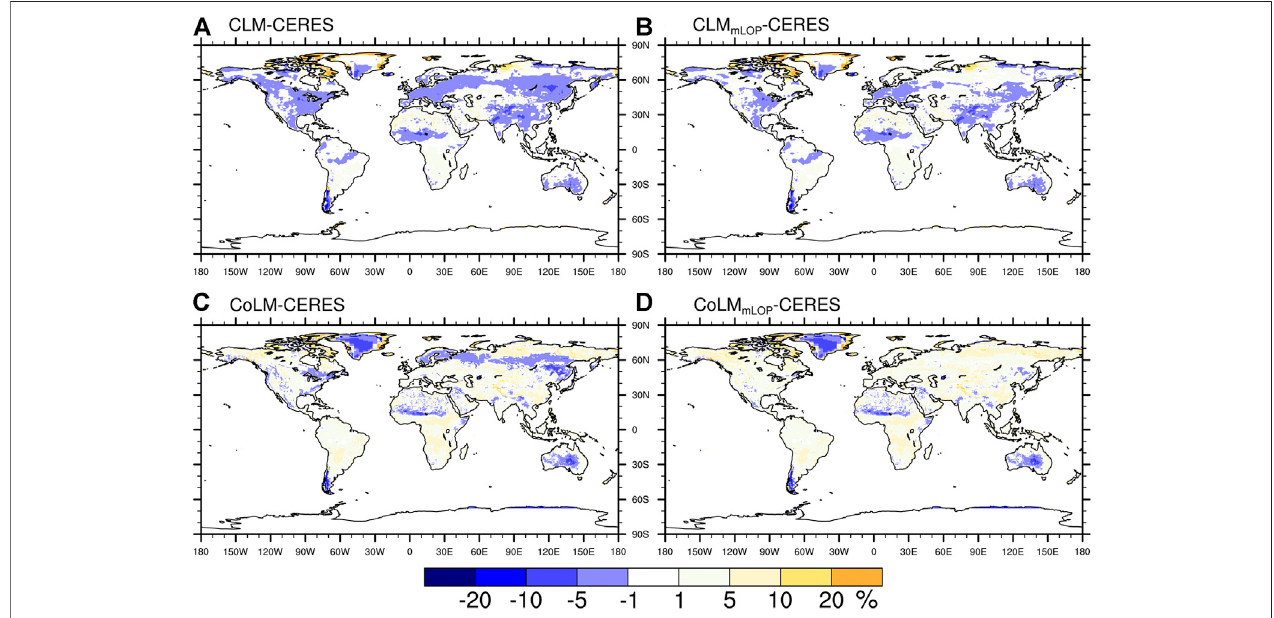
FIGURE 5 | Differences in all-sky albedo during JJA between CLM (A,B) [CoLM (C,D) ], CLM mLOP ( CoLM mLOP ) and CERES.